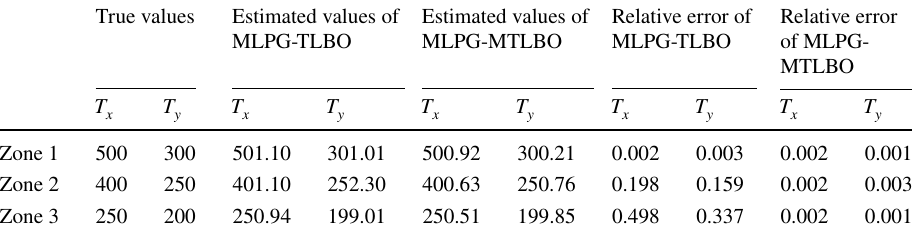
Table 2 Comparison of MLPG- TLBO and MLPG-MTLBO performance